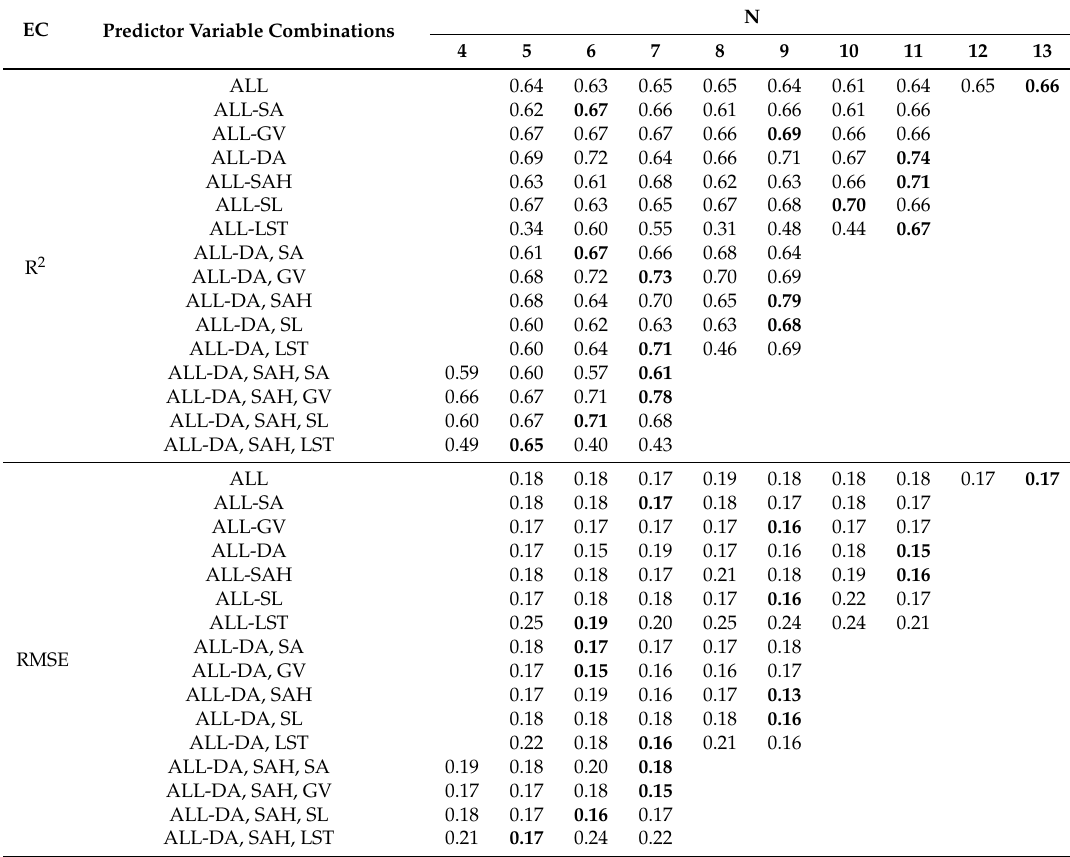
ANN model performances of the different predictor variable combinations for soil EC estimation.